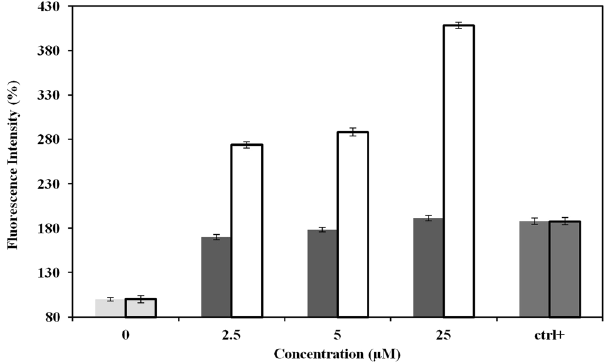
Figure 13. ROS generation in SNPs ■ and ASNPs □ treated MDA-MB-231 cells. Ctrl + represents positive control cells, which are treated by H 2 O 2 . Relative fluorescence of DCF was measured using a spectrofluorometer with excitation at 485 nm and emission at 530 nm. Each column represents the mean value of three measurements. The error bars were calculated by dividing the standard deviation by the square root of the number of measurements.